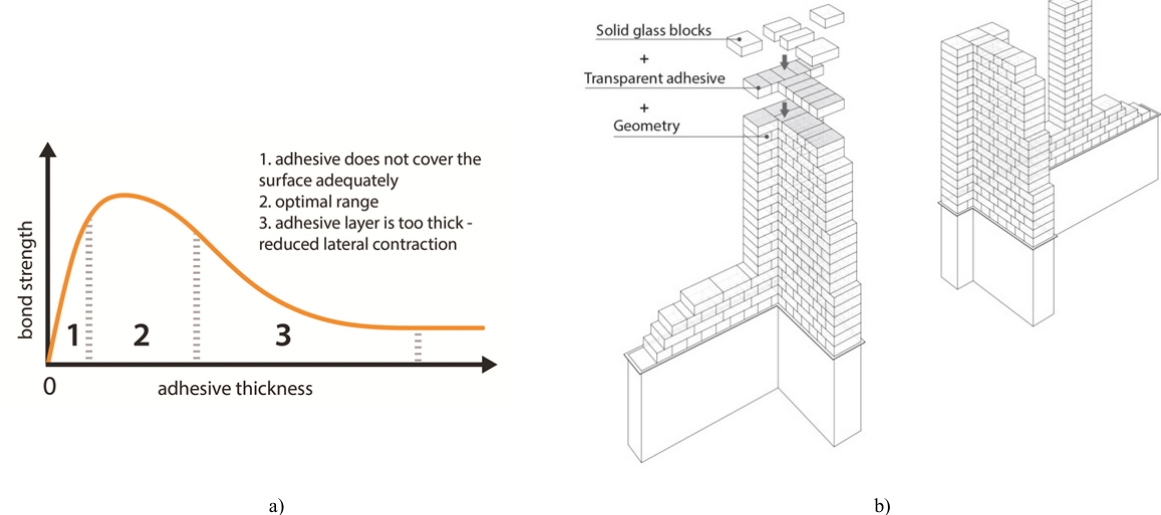
Fig. 3a. Schematic depiction of the relation between an adhesive’s optimum strength and thickness. Fig. 3b. Principle of the proposed adhesively bonded glass brick